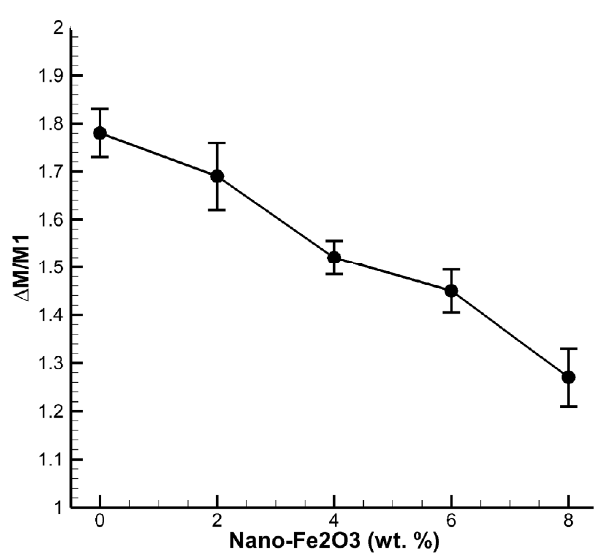
Fig. 1. Effect of Nano- Fe 2 O 3 addition on improvement of hydration resistance of MgO-CaO refractories [7].